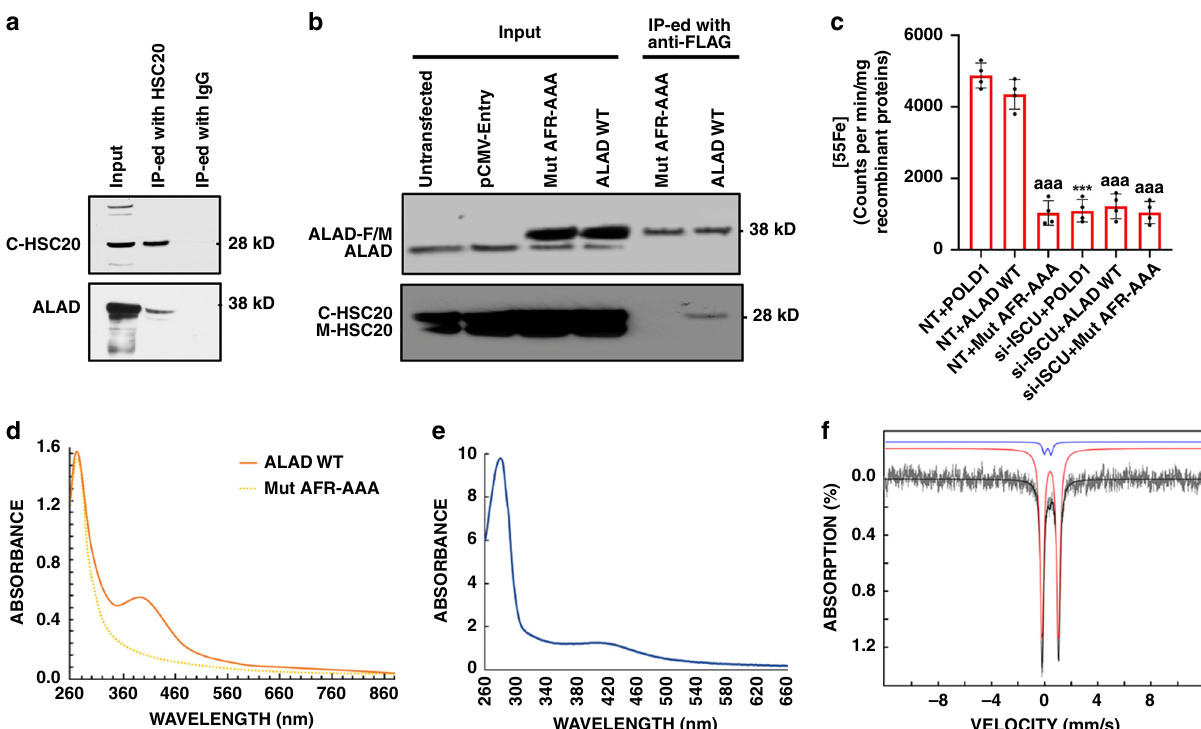
Fig. 1 Human ALAD coordinates a [Fe 4 S4] cluster. a Immunoprecipitation (IP) of cytosolic fractions of HeLa cells using anti-HSC20 antibody shows that ALAD co-precipitates with HSC20. The input was 5% of the cytosolic fraction lysate, and the remaining 95% of the lysate was subjected to IP with anti- HSC20 antibody. The eluates were then subjected to Western blotting with anti-HSC20 and anti-ALAD antibodies. The experiments were repeated twice independently with similar results b IP of whole-cell lysates of HeLa cells transfected with plasmids expressing C-terminally FLAG/MYC-tagged wild-type ALAD (ALAD WT) or the AFR to AAA mutant (Mut AFR-AAA). The inputs were 10% of lysates used in the IPs. Untransfected HeLa cells or HeLa cells transfected with empty vector (pCMV-Entry) were used as controls. The experiments were repeated twice independently with similar results. These results indicated that the AFR motif of human ALAD was important for its interaction with HSC20. c 55 Fe incorporation into C-terminally FLAG/MYC- tagged POLD1 (POLD1), ALAD WT and Mut AFR-AAA in HEK293 cells transfected with nontargeting siRNA (NT) or On-TARGETPlus siRNA pools against human ISCU (si-ISCU). The data are presented as mean values ± standard deviations of n = 4 biologically independent samples. Two-sided unpaired Student ’ s t -test was employed to analyze statistical signi fi cance. No multiple comparison was performed. *** P < 0.001 versus the “ NT + POLD1 ” group; aaa P < 0.001 versus the “ NT + ALAD WT ” group. The exact P values are provided in the Source Data fi le. d UV-vis spectra of C-terminally FLAG/MYC- tagged ALAD WT (orange line) and Mut AFR-AAA (yellow line) that were expressed in Expi293 cells and puri fi ed anaerobically. e UV-vis spectrum of the MBP-ALAD puri fi ed anaerobically from E. coli showing absorbance at 420 nm. f Experimental 4.2-K/53-mT Mössbauer spectrum of the MBP-ALAD puri fi ed anaerobically from E. coli (black vertical bars) and simulation (black solid line) along with contributions from individual subspectra associated with [Fe 4 S 4 ] 2 + (red line) and [Fe 2 S 2 ] 2 + clusters (blue line) with parameters quoted in the